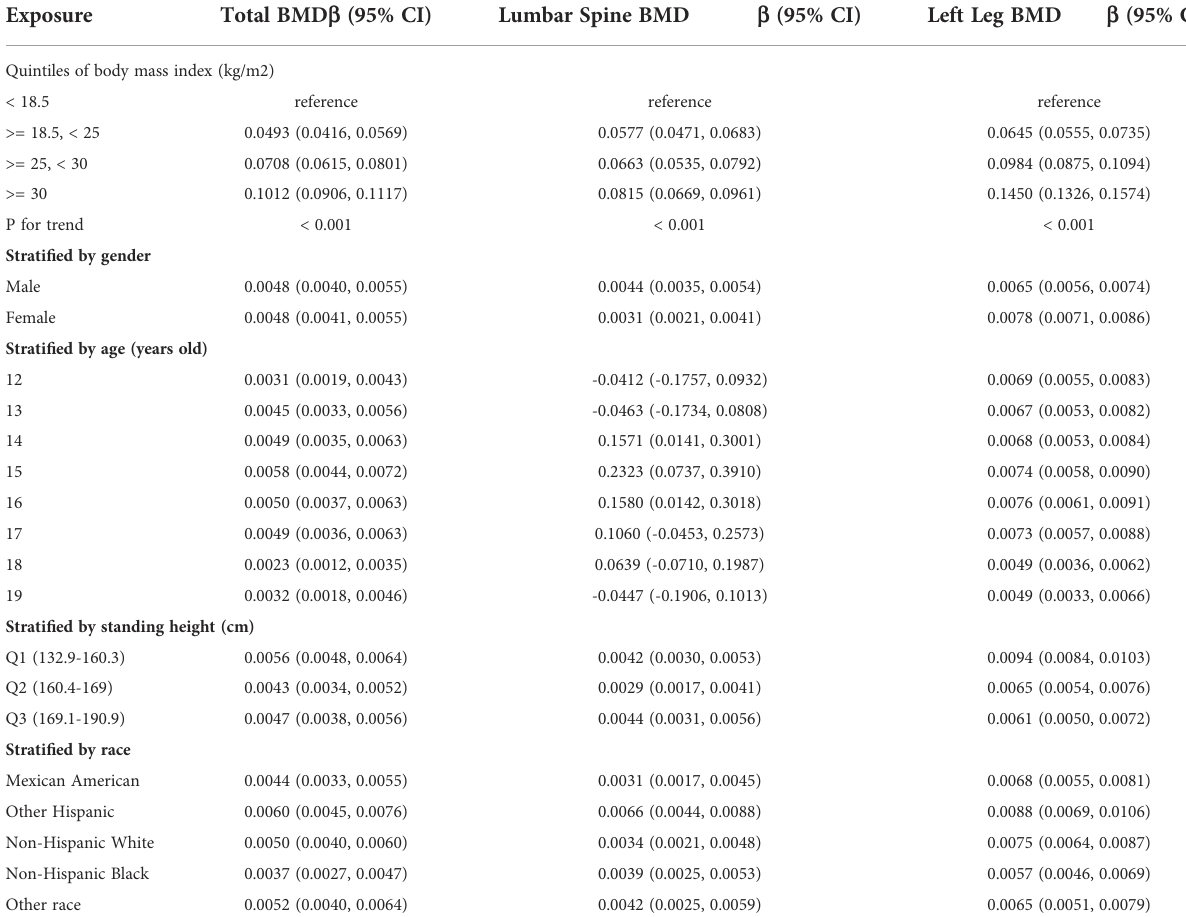
TABLE 2 Association between body mass index (kg/m 2 ) and bone mineral density (g/cm 2 ).